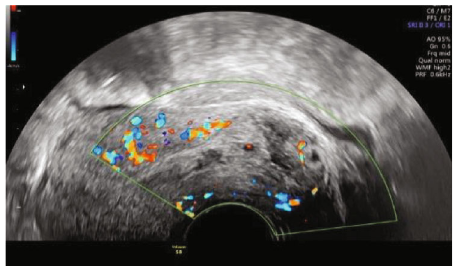
Figure 2: Color Doppler study did not provide new datafor